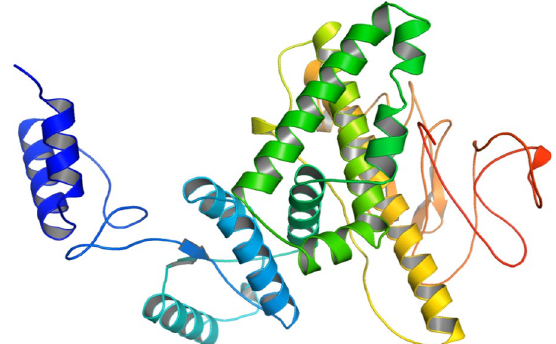
Fig. 5 A cartoon representation of the tertiary structure of the vaccine